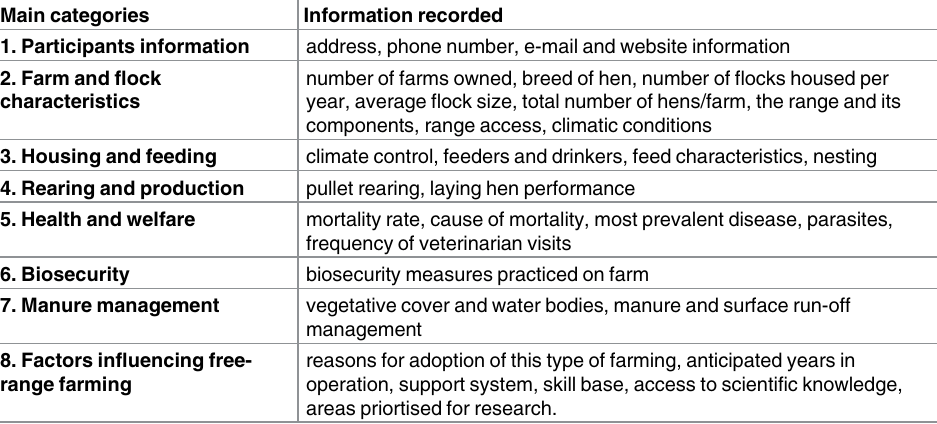
Table 1. Main categories and information within each category recorded in the survey